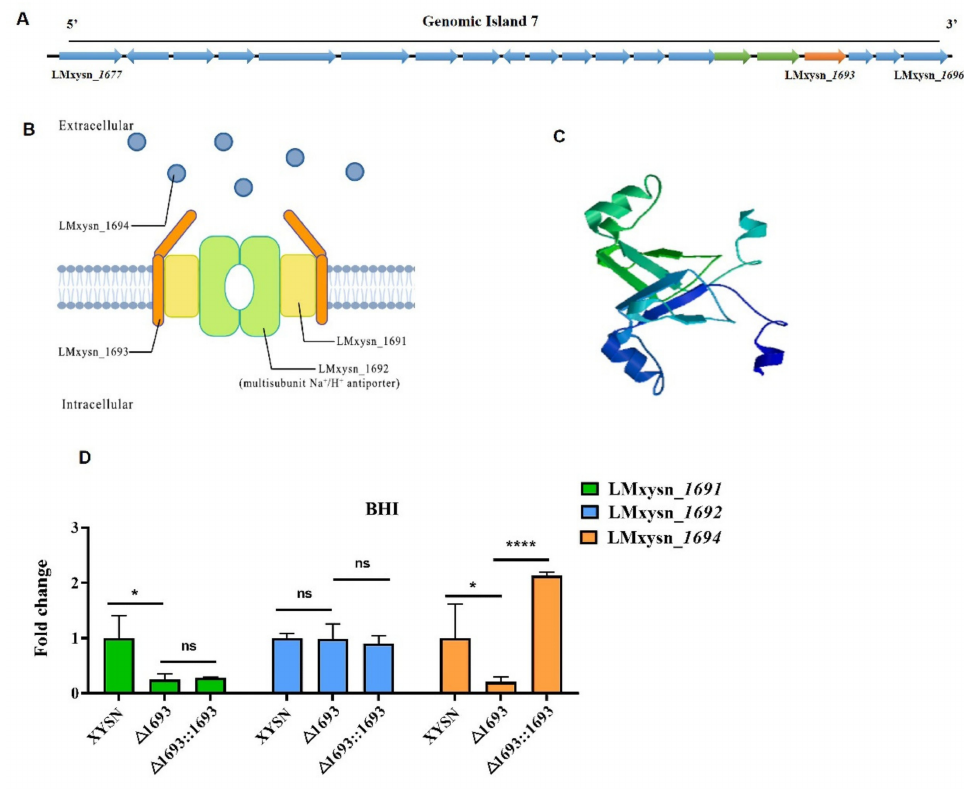
Figure 1. Bioinformatics analysis of XYSN GI-7. All genes located in GI-7 are shown in ( A ). The cellular localization and function of the proteins encoded by LMxysn_ 1691 , LMxysn_ 1692 and LMxysn_ 1693 were predicated via Biorender (Toronto, Canada) (https://biorender.com/ (accessed on 5 May 2022)) ( B ). Three-dimensional structure was predicted of the protein encoded by LMxysn_ 1693 gene ( C ). The expression levels of Lmxysn_ 1691 , Lmxysn_ 1692 and Lmxysn_ 1694 genes were detected with LMxysn_ 1693 deletion strain by qRT-PCR ( D ). Error bars represent SD, n = 3 independent experiments. Statistical analysis was performed using Student’s t -test: ns, no significance; * p < 0.05, **** p <